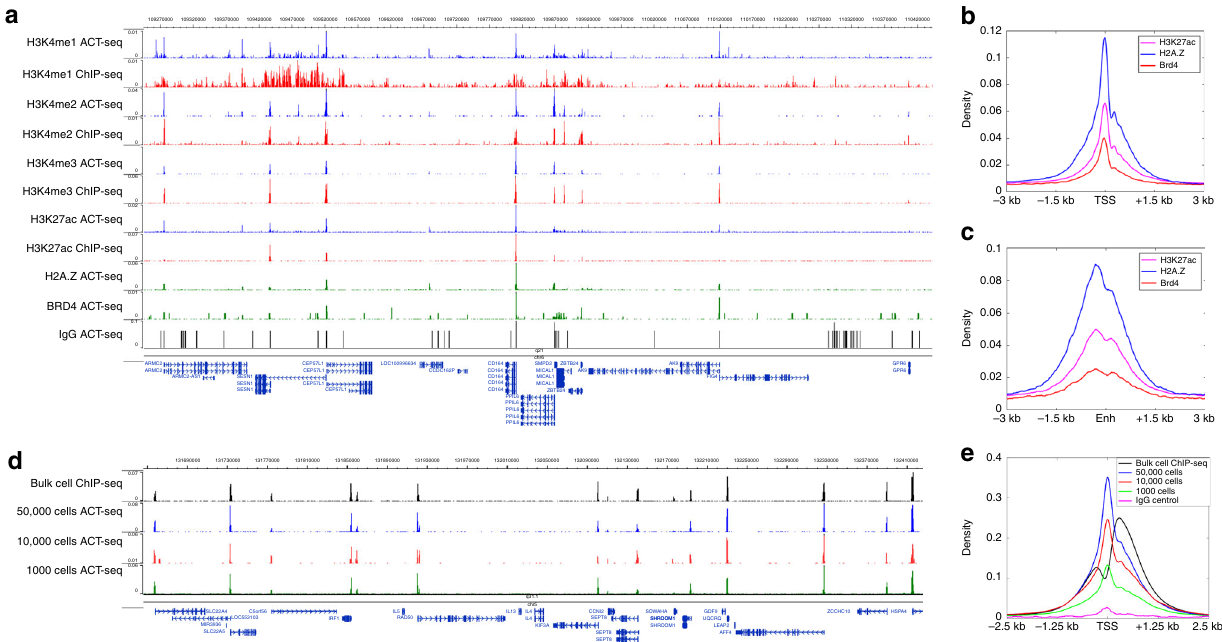
Fig. 1 ACT-seq robustly maps epigenetic marks in bulk-cell samples. a Genome browser image depicting enrichment of the indicated epigenetic factors in HEK293T cells at a representative genomic region. Data were obtained using ACT-seq (blue, green) or ChIP-seq (red). The ChIP-seq samples were obtained from published ENCODE data sets. A mock IgG sample (aggregated from all ACT-seq IgG replicates) is included as a comparative control for enrichment. b Metagene pro fi le of average H3K27ac, H2A.Z, and Brd4 enrichment at the transcription start site (TSS) region of annotated genes from the hg19 genome. c Metagene pro fi le of average H3K27ac, H2A.Z, and Brd4 enrichment at enhancer (Enh) regions. Enhancers were identi fi ed as